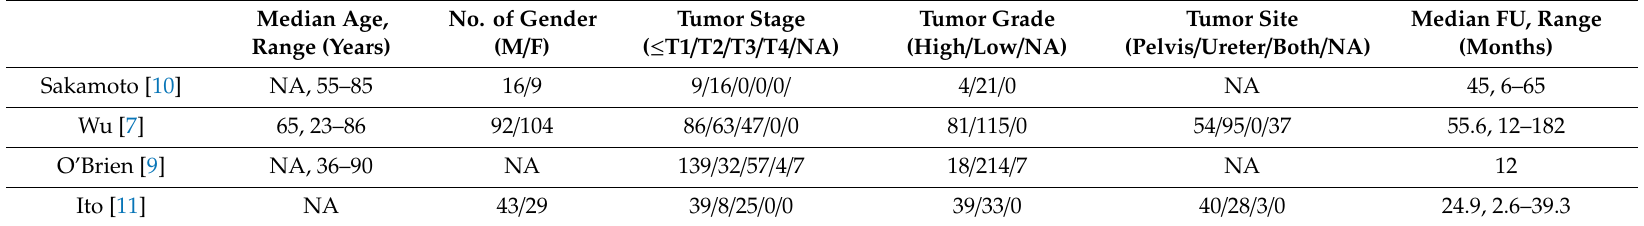
Table 2. Patient characteristics from eligible